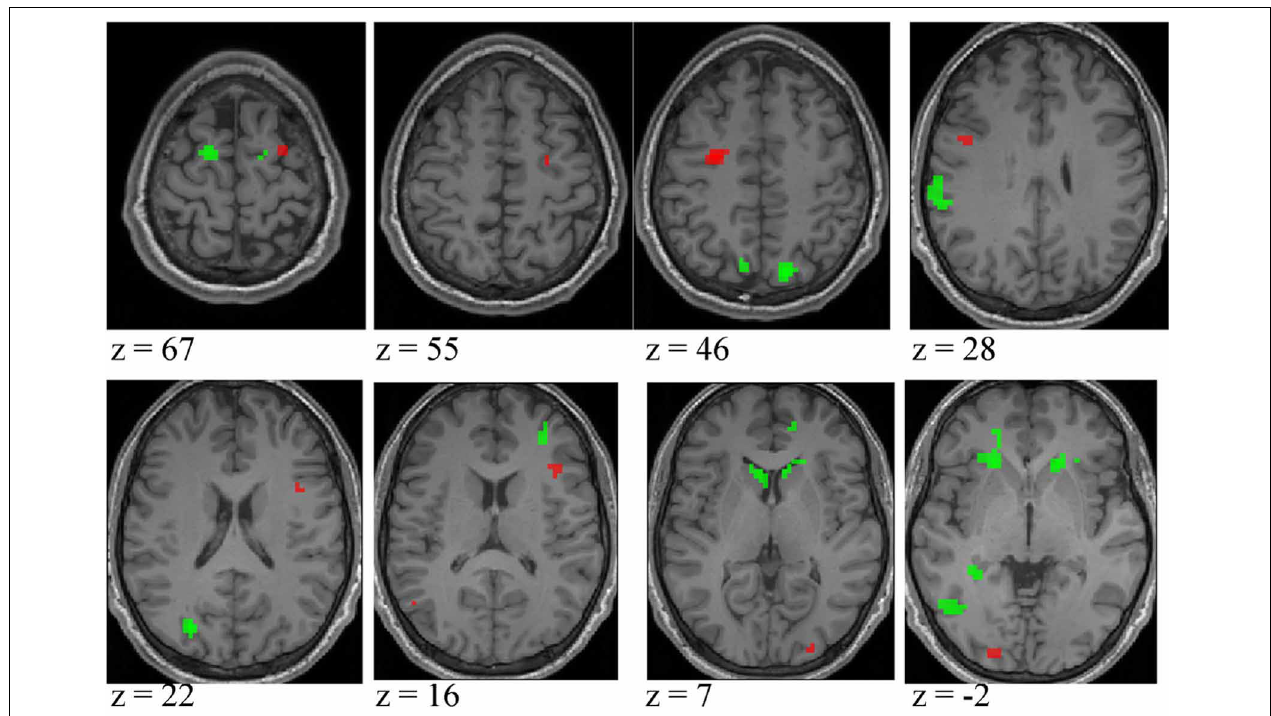
FIGURE 7 | Activation differences between higher- and lower-skilled males (red) and between lower-skilled males and females (green) in soccer action identification tasks at p < 0 . 05 FWE corrected, minimum cluster size = 5 voxels. Data are combined